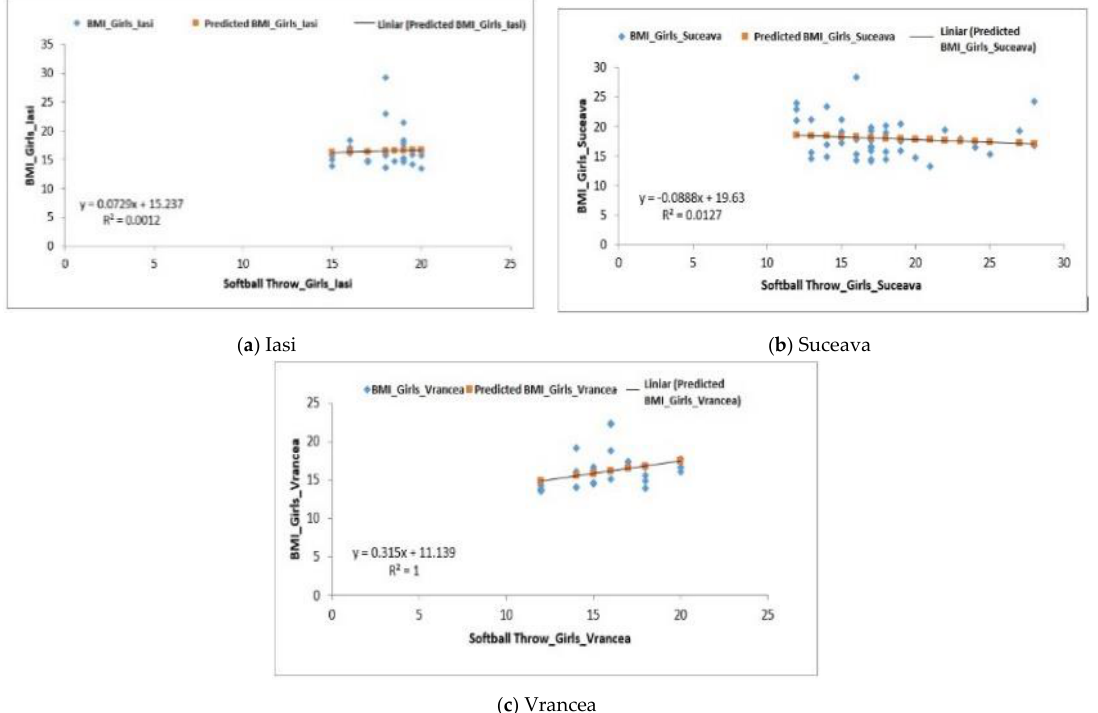
Figure 4. Relationship between the BMI and the softball throwing test for the female subjects in the three regions.